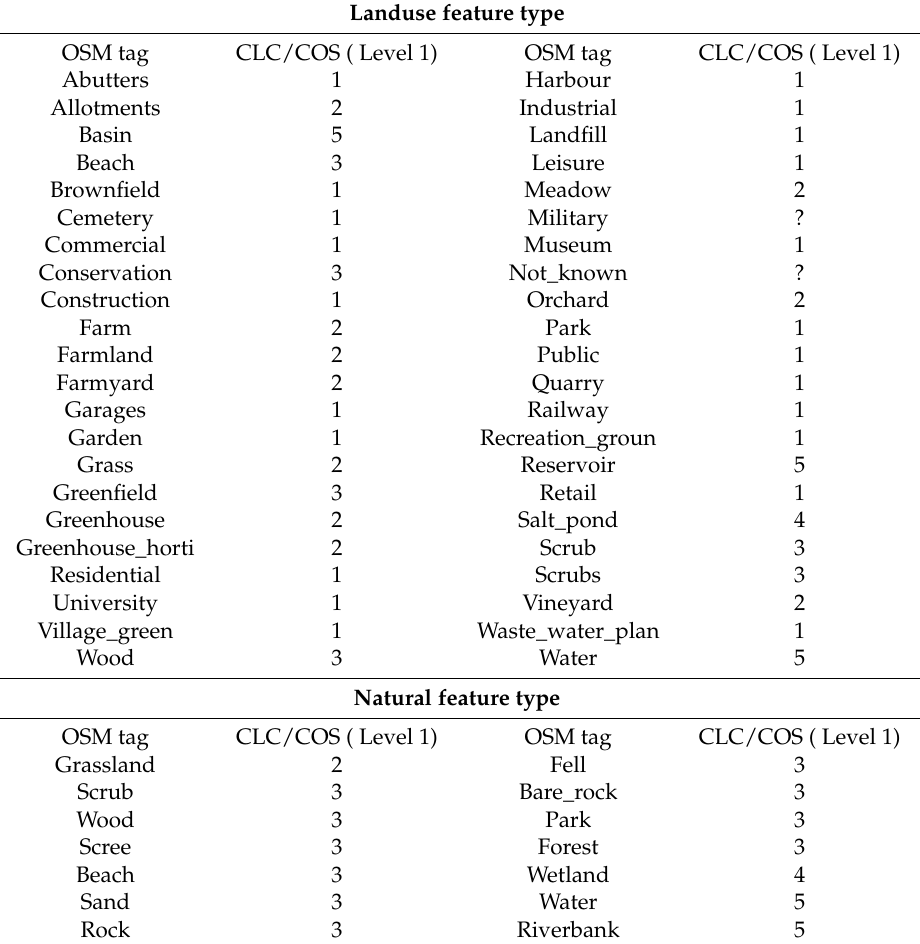
Table 3. Nomenclature correspondence for the first level of the CLC and COS